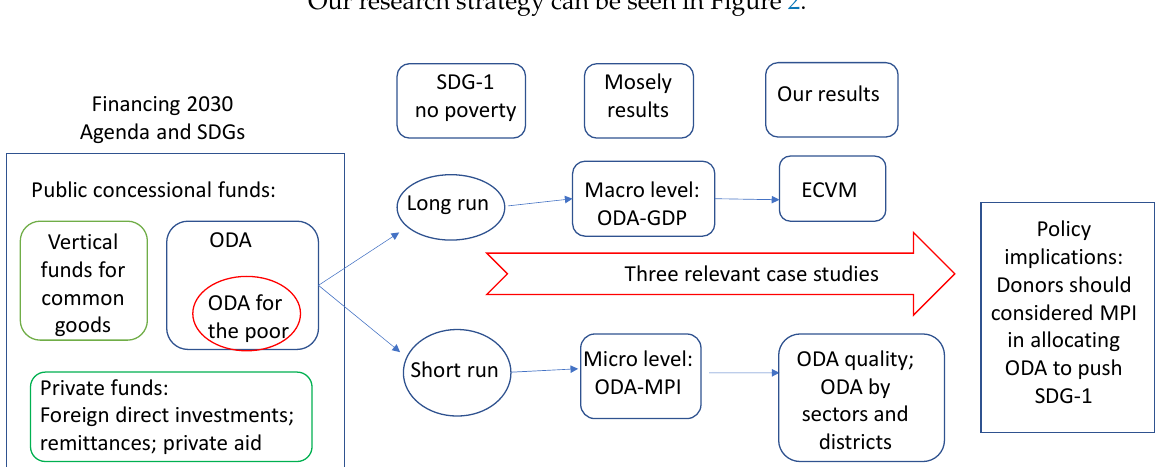
Table 1. Economic structure: selected indicators (in percentage of GDP).